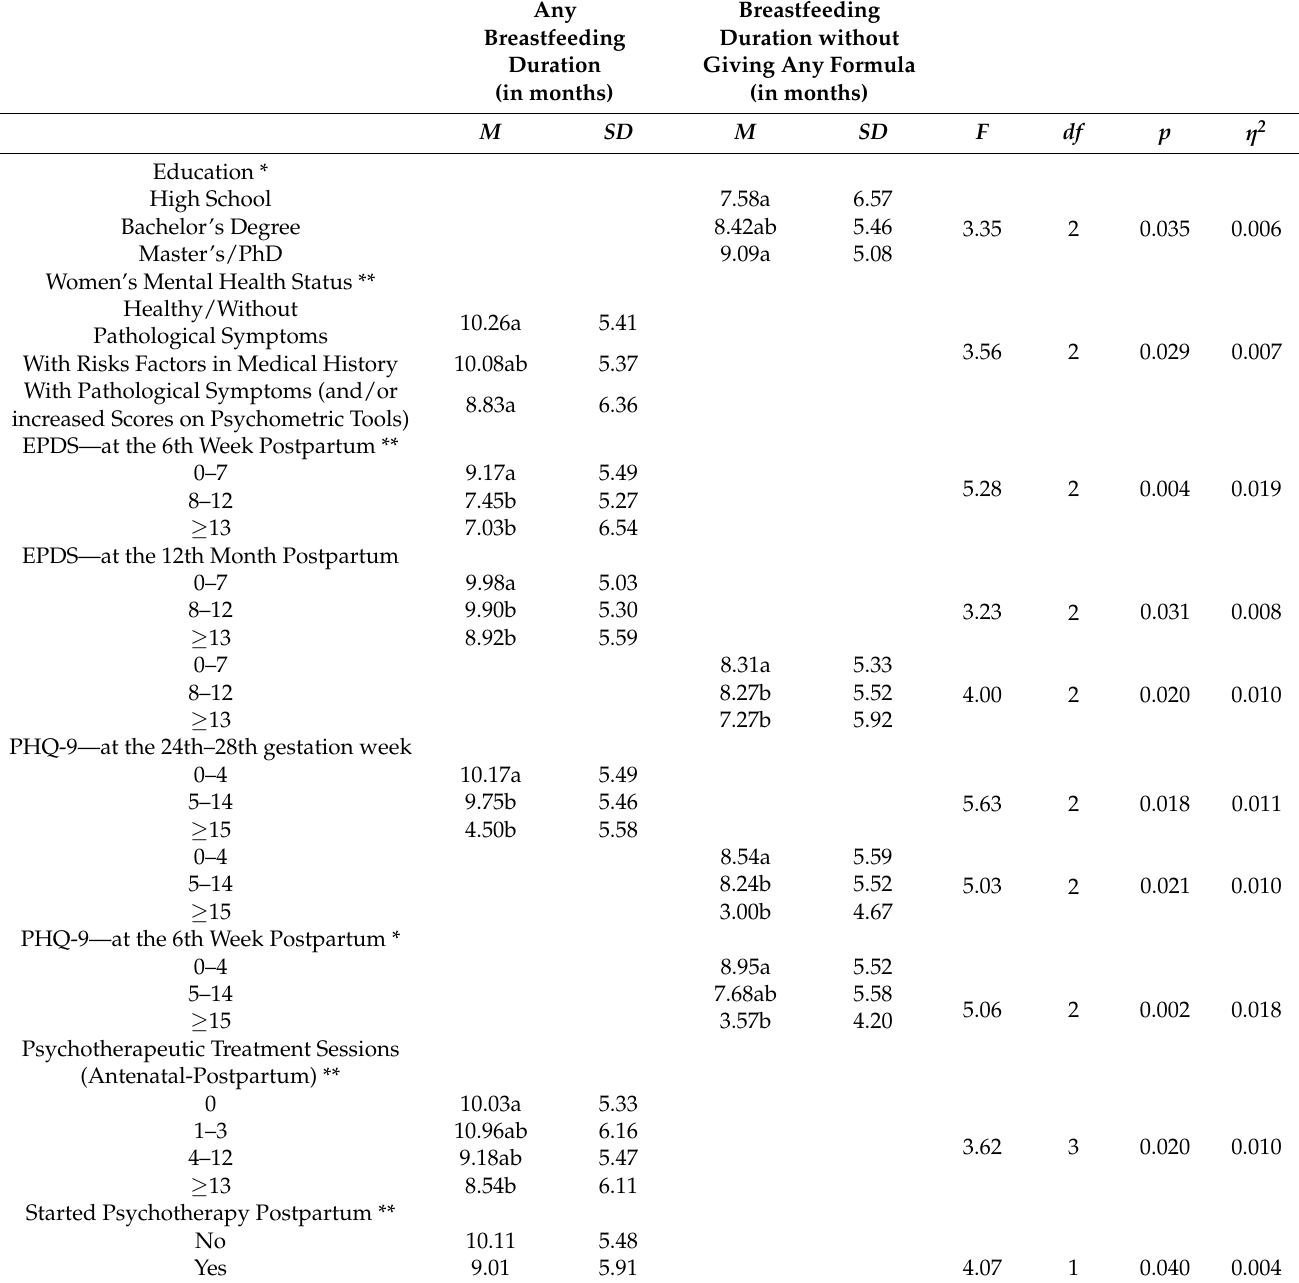
Table 4. Multivariate analyses of variance of any breastfeeding duration and duration of breastfeeding without giving any formula according to maternal mental health characteristics in the perinatal